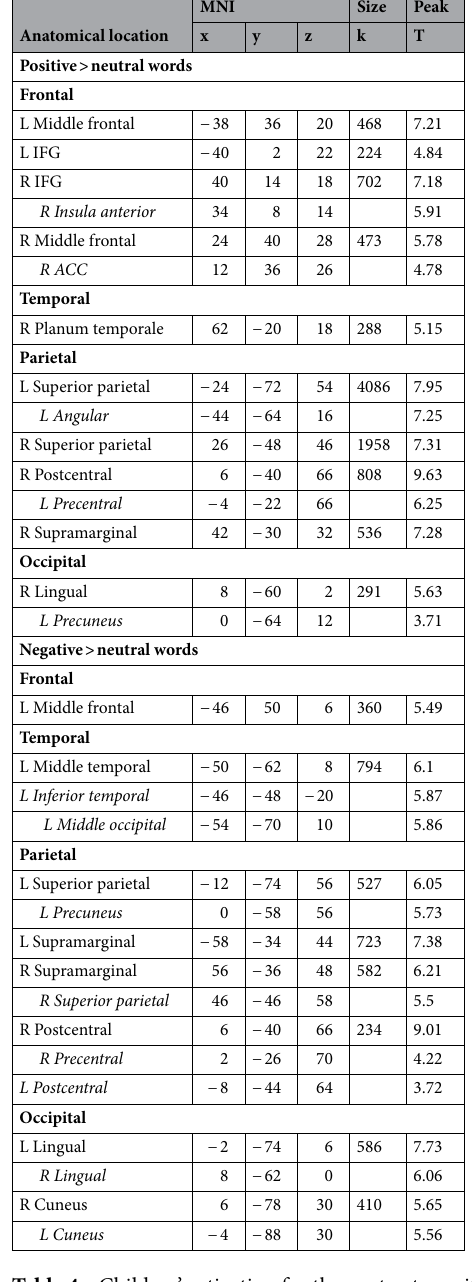
and cuneus (see both contrasts in Table 4, Fig. 1C). The conjunction analysis for positive > neutral and negative > neutral words showed activations in bilateral superior parietal gyrus (left: k = 309, T = 5.94, [− 24 − 72 54], including precuneus, T = 5.46, [0 − 56 54], right: k = 275, T = 5.45, [46 − 46 58]), left hemispheric supramarginal (k = 477, T = 6.81, [− 56 − 34 44]) and middle temporal (k = 437, T = 5.59, [− 48 − 64 10]) and right hemispheric postcentral (k = 164, T = 9.01, [65], including